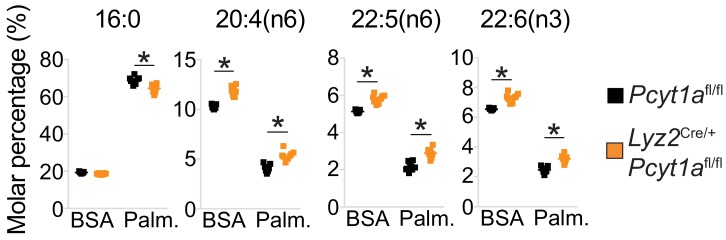
Pcyt1a deficiency increases total PUFA levels in macrophages.Relative abundance of indicated fatty acids in Pcyt1afl/fl (n = 7) or Pcyt1afl/fl
Lyz2Cre/+ (n = 8) BMDMs in a basal state or after 16 hr treatment with 250 μM palmitate.